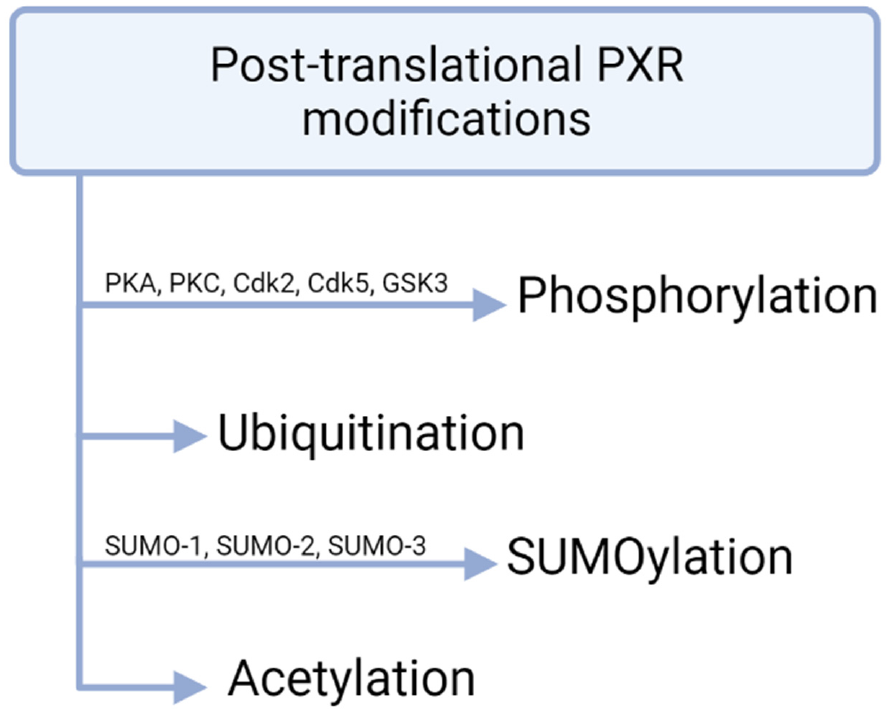
Figure 3. PXR modifications. Phosphorylation of PXR mostly reduces transcriptional activity. Ubiquitination is mediated by the 26S proteasome and SUMOylation takes place in lysine residues. Post-translational acetylation of PXR has been shown in vivo. There is evidence that PXR acetylation interacts with PXR SUMOylation and may be mutually excluded, but further research is needed